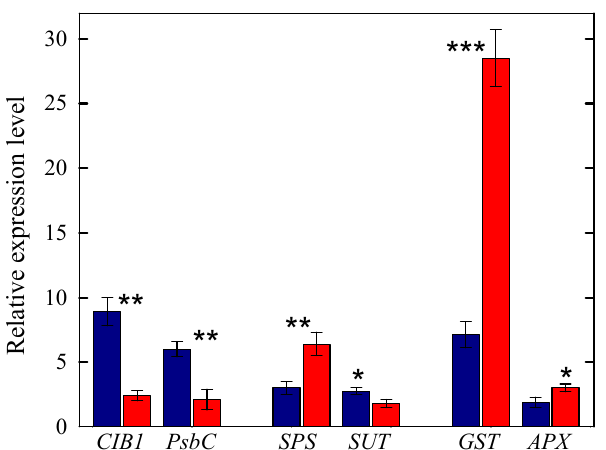
Figure 2. Relative expression levels of selected genes regulating light response ( CIB1 , PsbC ), the synthesis and transport of sugars ( SPS , SUT ), and the oxidative stress response ( GST , APX ) in shade (blue bars) or sun (red bars) leaves of C. incanus . Data are means ± standard deviation ( n = 3). Asterisks denote significant difference: *** P < 0.001; ** P < 0.01, * P < 0.05.